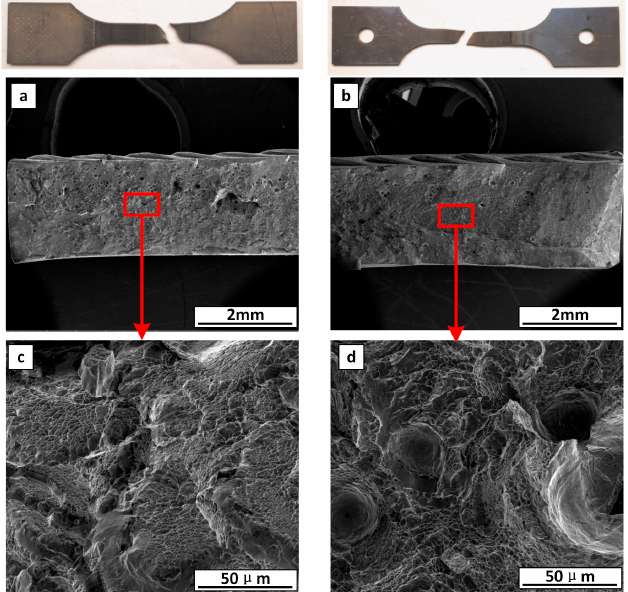
Figure 7. Fracture surface of welded joints: ( a ) fracture surface after tensile test performed at room temperature; ( b ) fracture surface after tensile test performed at 650 °C; ( c ) high magnification of the red box in ( a ); ( d ) high magnification of the red box in ( b ).